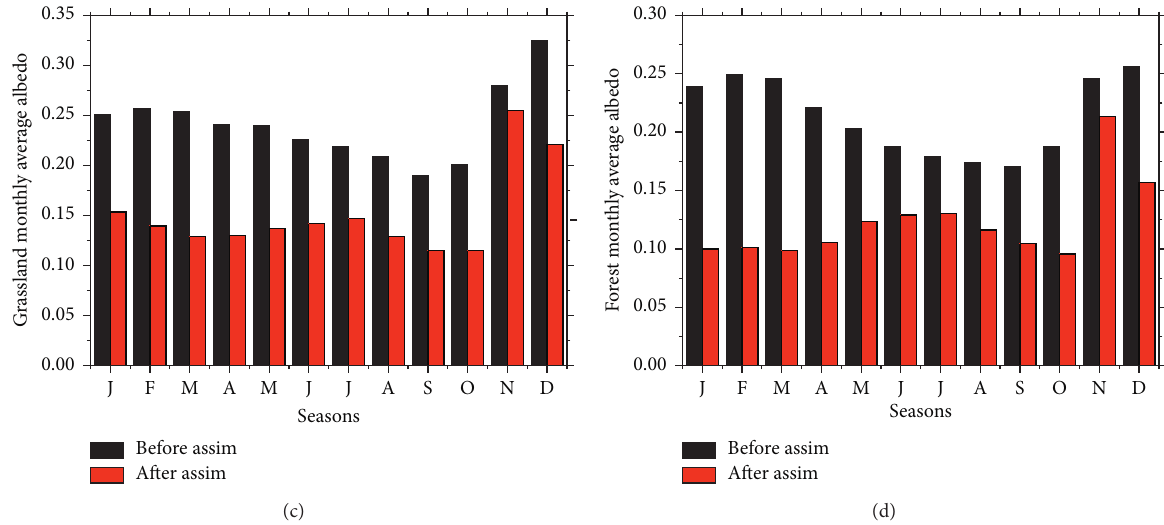
Figure 7: Spatial average of the monthly average albedo simulations before and after assimilation for the four main LUCs: (a) urban; (b) cropland; (c) grassland; (d) forest.